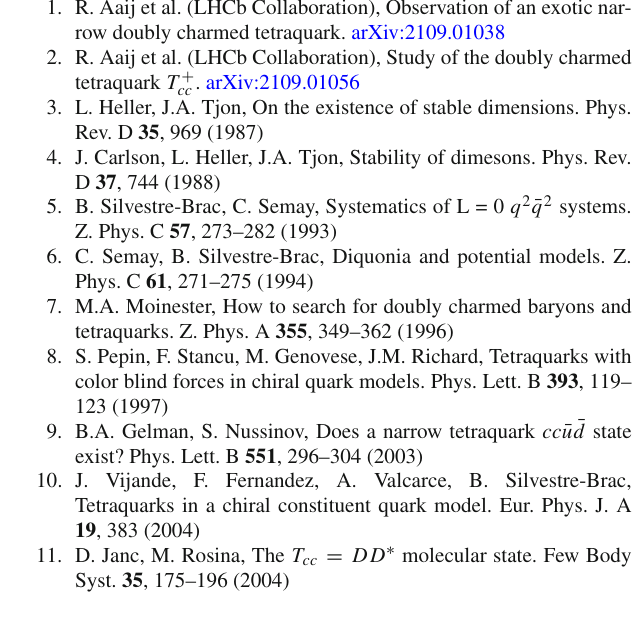
Fig. 4 The Dalitz plot for the p + T + cc → p + D + + D 0 reaction with cutoff (cid:21) = 1 GeV. For each example choice of p p , the figures represent the m D + D 0 − m pD 0 (left) and m pD + − m pD 0 (right) planes, showing the invariant mass m ij = and j . The colorbox means the ratio of event number in a bin of 0.005 GeV × 0.005GeVtothetotalnumberofevents.Theresultsareobtained with 10 8